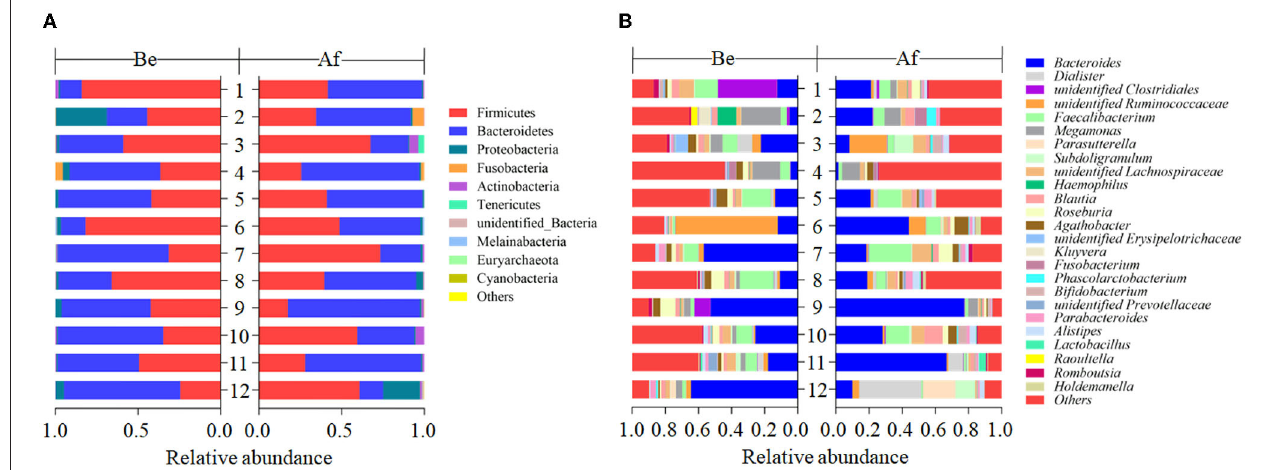
FIGURE 1 | The compositions of fecal gut microbiota before (Be) and after (Af) the 14-day dietary Laminaria japonica intake at the phylum level (A) and genus level (B) .